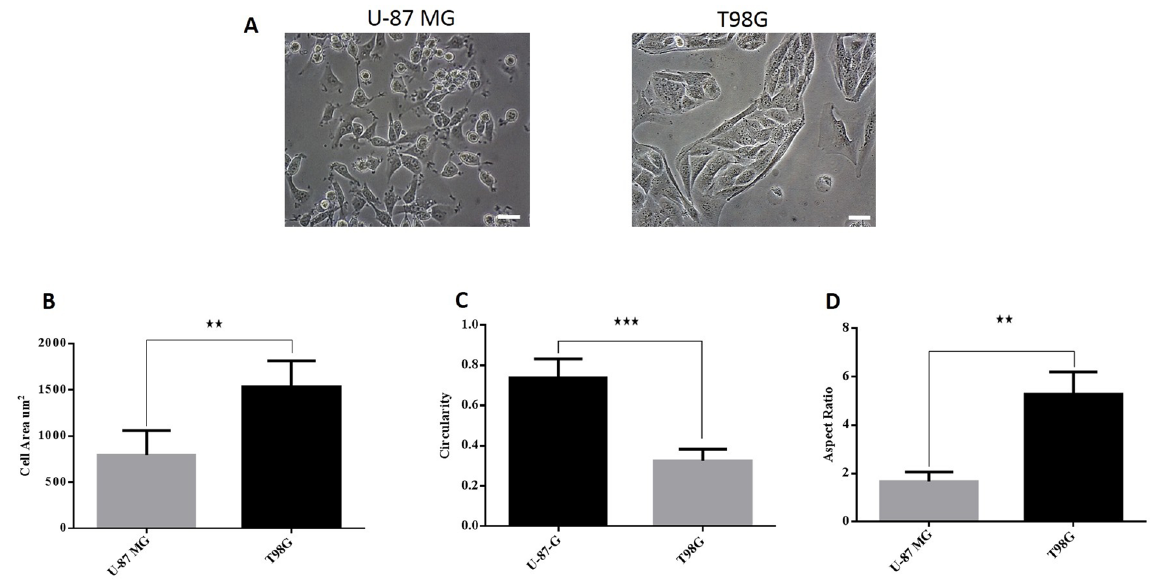
Figure 3. Cellular shapes of T98G and U-87 MG cells. ( A ) U-87 MG cells and T98G cells showed spindle-like morphology. Scale bar = 200 µm. ( B ) The mean cell area of U-87 MG and T98G cells shows that T98G cells have a larger area compared to U-87 MG cells. ( C ) Cell circularity confirms that U-87 MG cells have a higher (mean) circularity value compared to T98G cells. ( D ) T98G cells have a higher aspect ratio ~ 5 than U-87 MG (aspect ratio ~ 2).